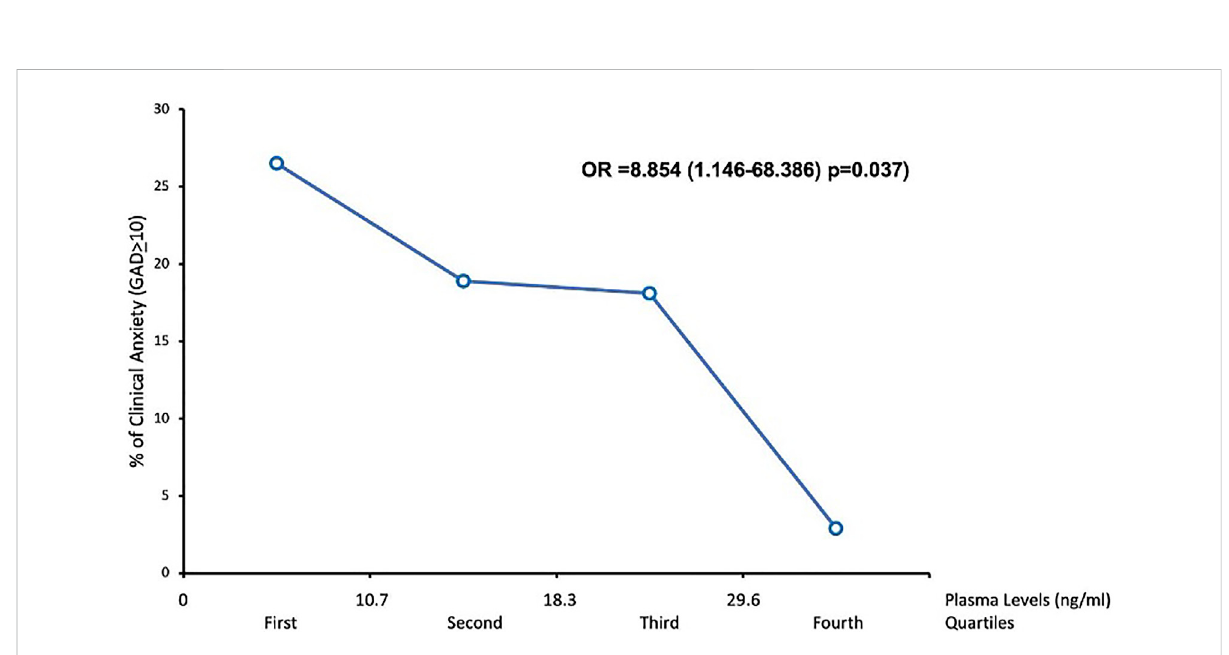
FIGURE 2 Association between CBD plasma levels and anxiety